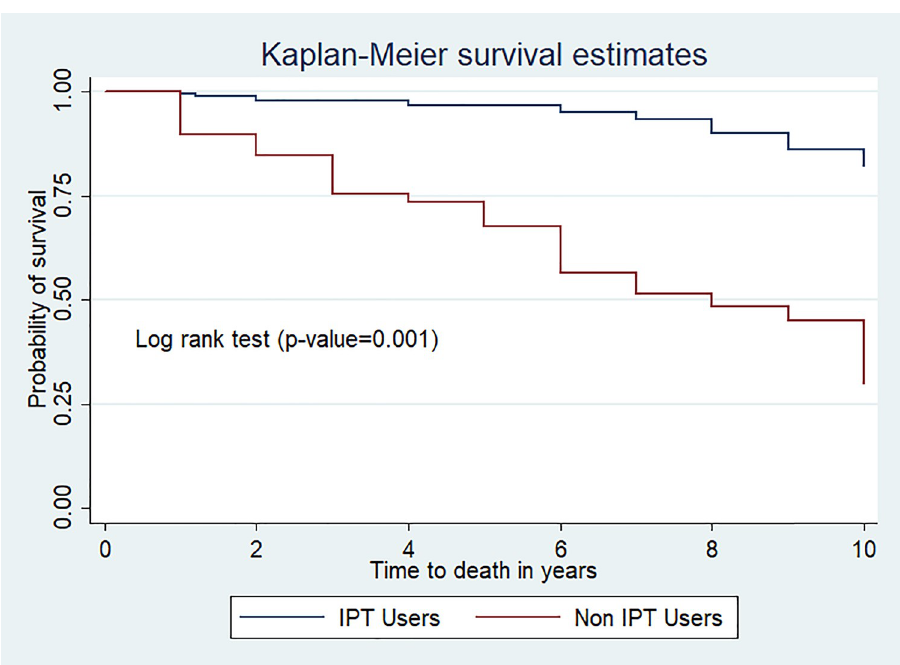
Fig 3. Kaplan Meier survival curve of IPT use among TB/HIV co-infected children at public hospitals, Southern Ethiopia, 2020.